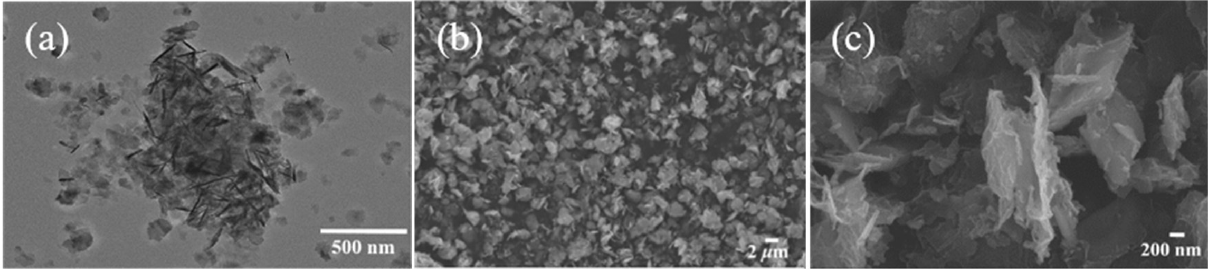
Figure 8. ( a ) TEM; ( b ) low-magnification and ( c ) high-magnification SEM images of the NiCo 2 S 4 /rGO composites.